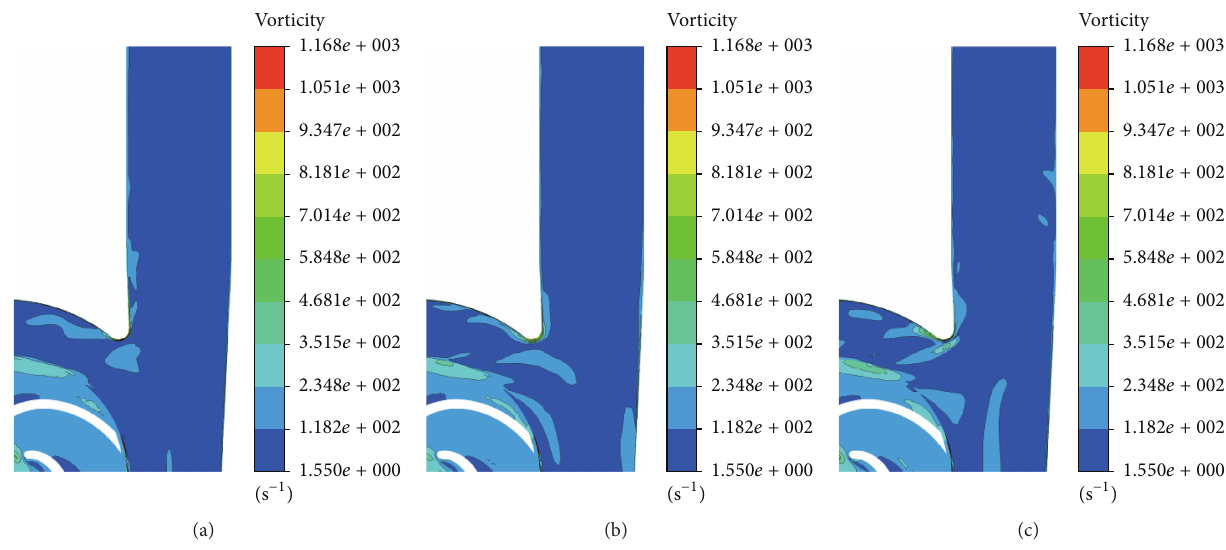
Figure 8: Vorticity distribution on the middle section: (a) M1, (b) M2, and (c) M3.